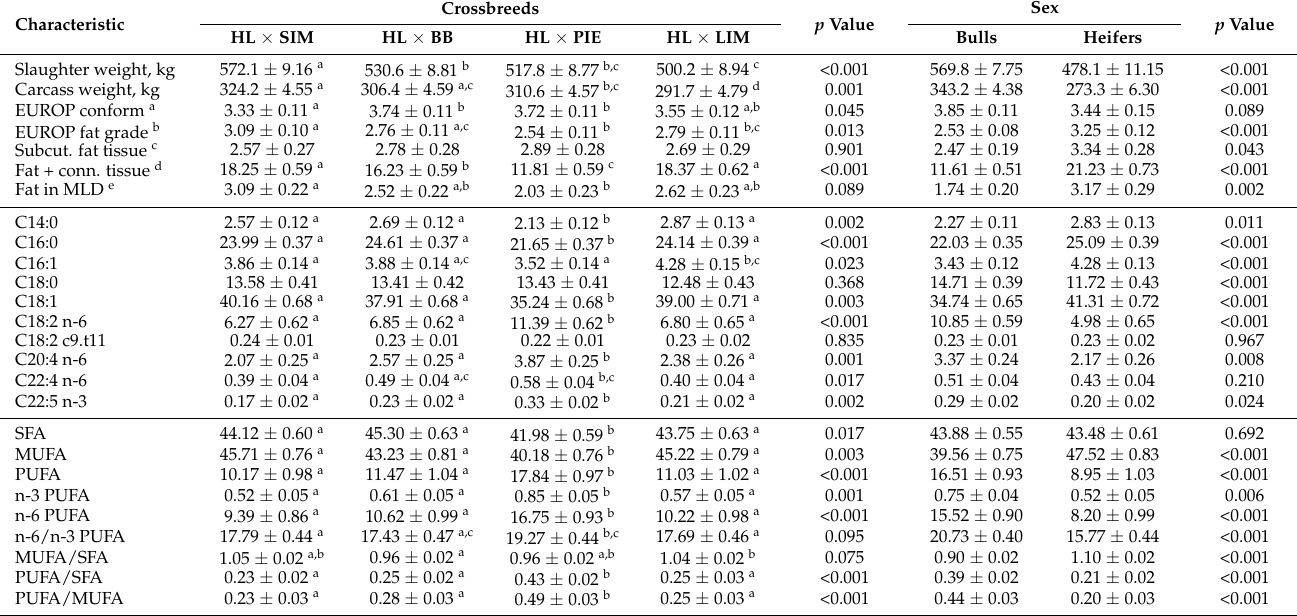
Table 2. Average value (LS Mean ± SE and p -value) of carcass fatness and fatty acids composition in the m. longissimus dorsi by crossbreeds and sex of